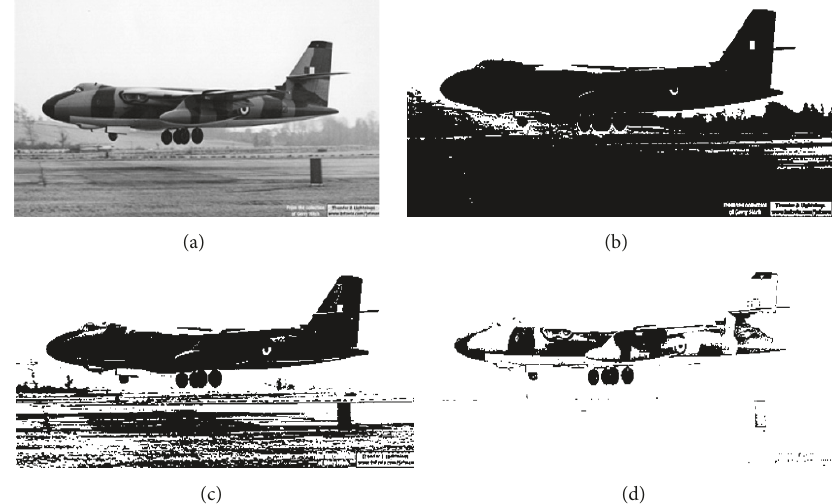
Figure6:Segmentationofairplaneimage.(a)Horseoriginal.(b)Segmentationofone-dimensionalOtsu.(c)Thetraditionaltwo-dimensional Otsu method. (d) Our